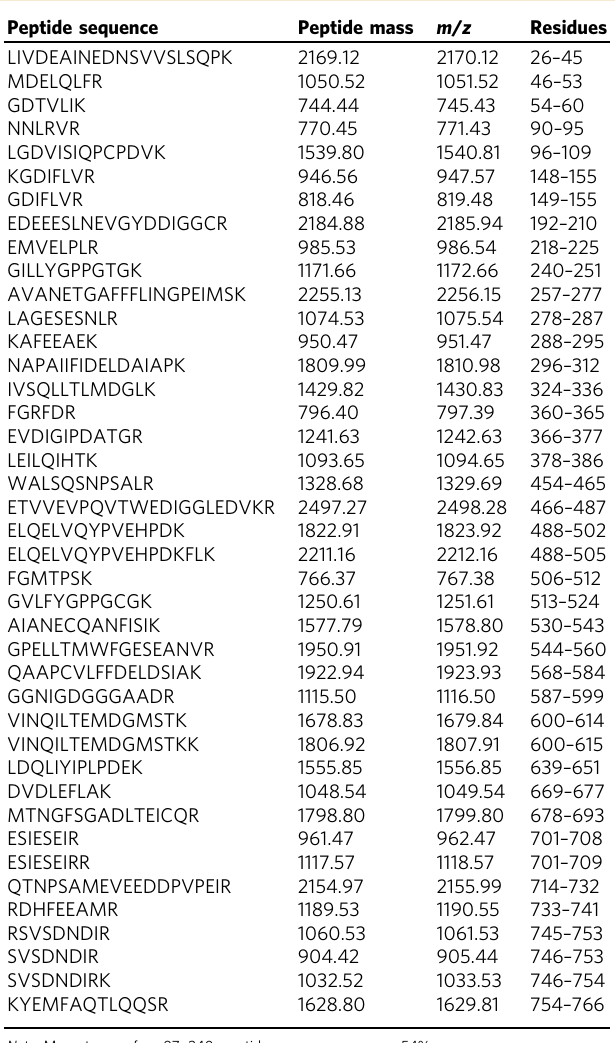
(vGluT1), an excitatory presynaptic marker. Consistent with the reduction in cell surface expression of GluA1 in HEK293 cells (Fig. 2e, f), overexpression of p97 reduced the intensity of postsynaptic surface clusters of GluA1, but not GluA2 (Fig. 2g, h).